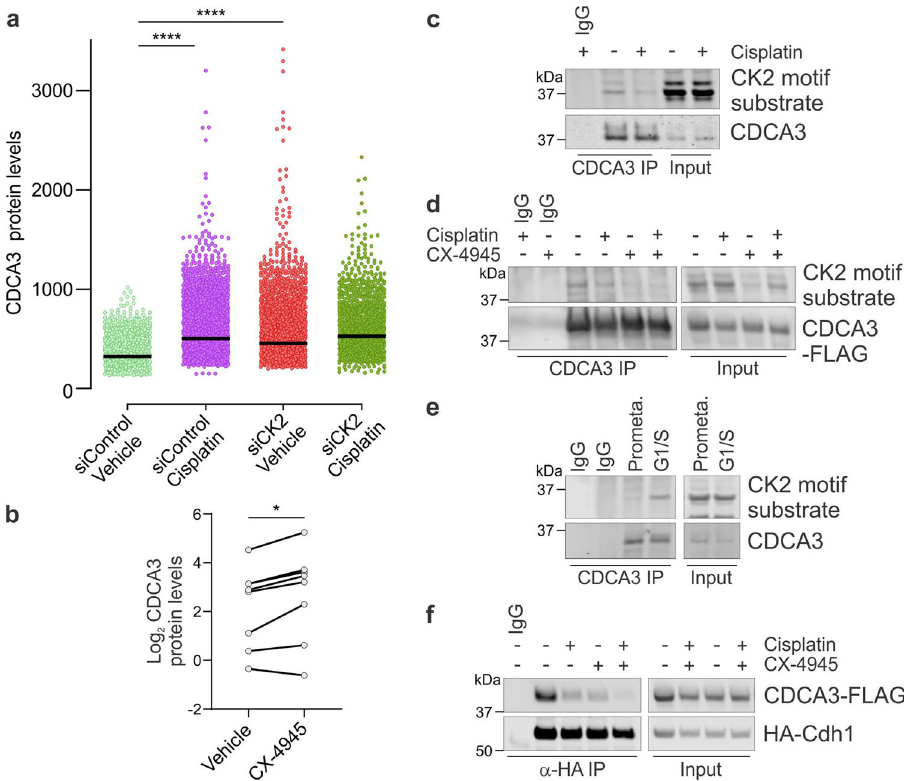
Fig. 5 Phosphorylation of CDCA3 by CK2 promotes its degradation by the APC/C Cdh1 . a Beeswarm plot showing CDCA3 levels assessed in control or CK2 depleted H460 cells that were treated with or without cisplatin. CDCA3 levels determined by analysis of high throughput immuno fl uorescence microscopy images. Data points represent CDCA3 levels within individual cells from a minimum of 1200 cells (see Supplementary Fig. 3a). Horizontal lines indicate median values (unpaired Student ’ s t test, **** P = < 0.0001). b Densitometry quanti fi cation of western blot analysis in Supplementary Fig. 3b, with dot points representing average log2 of relative endogenous CDCA3 levels from NSCLC cell lines treated with or without CX-4945. Representative of three independent experiments with lines connecting respective untreated and cisplatin treated cell lines (paired Student ’ s t test, * P = 0.0126). c Immunoprecipitation analysis of endogenous CDCA3 to assess the CK2-mediated phosphorylation of CDCA3 in untreated or cisplatin treated H460 cells. d Immunoprecipitation analysis of ectopic CDCA3 from H460 cell lysates to assess the impact of cisplatin, CX-4945 or combination of both upon CK2-mediated phosphorylation of CDCA3. e Immunoprecipitation analysis to assess CK2-mediated phosphorylation of enriched endogenous CDCA3 from nocodazole arrested H460 cells in prometaphase (prometa.) or H460 cells arrested at the G1/S cell cycle boundary by double thymidine block. c – e CK2 phosphorylation assessed using antibody speci fi c for CK2 phosphorylation motifs within substrates. f Immunoprecipitation analysis of ectopic HA-Cdh1 with ectopic wild-type CDCA3-FLAG from H460 cells treated with cisplatin, CX-4945 or a combination of both. All in vitro experiments are representative of three independent